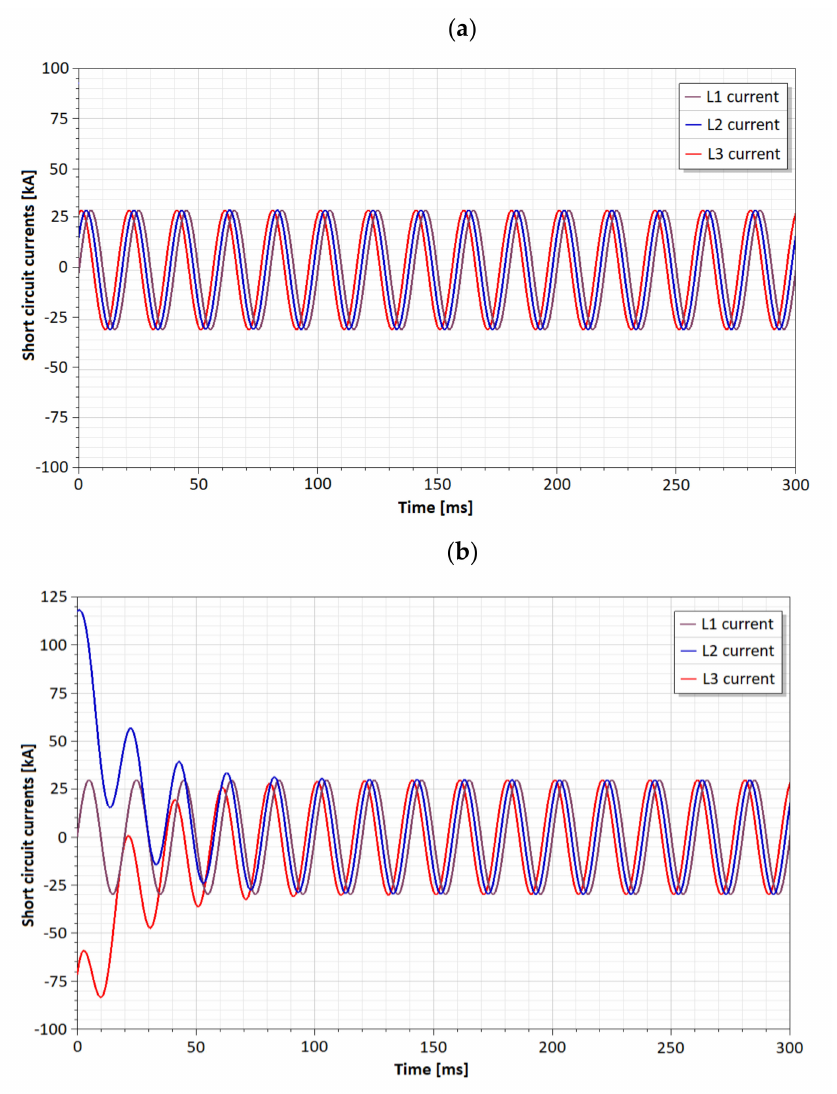
Figure 5. Current waveforms and their squares in the case of a single-phase short circuit current in the circuit: ( a ) symmetrical, ( b )